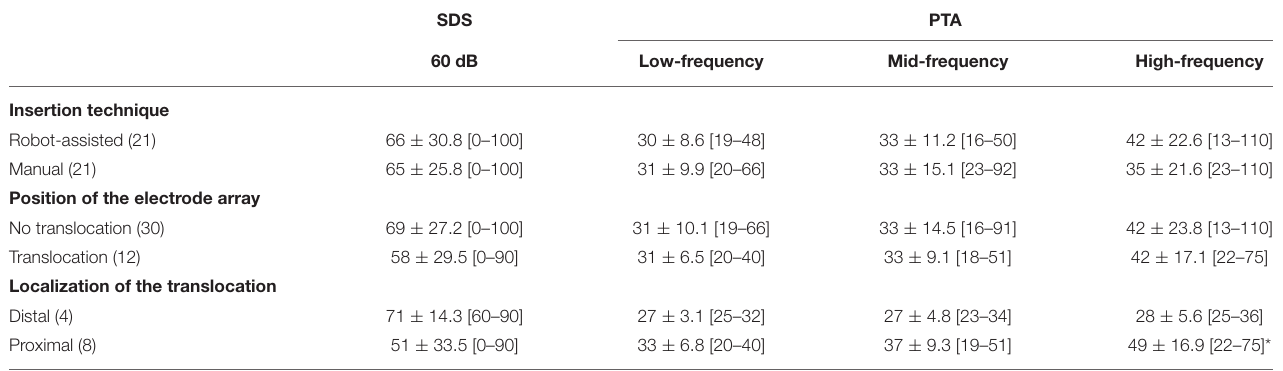
TABLE 2 | Hearing outcomes according to electrode array insertion technique, array translocation, and distal ( > 180 ◦ ) and proximal ( < 180 ◦ )